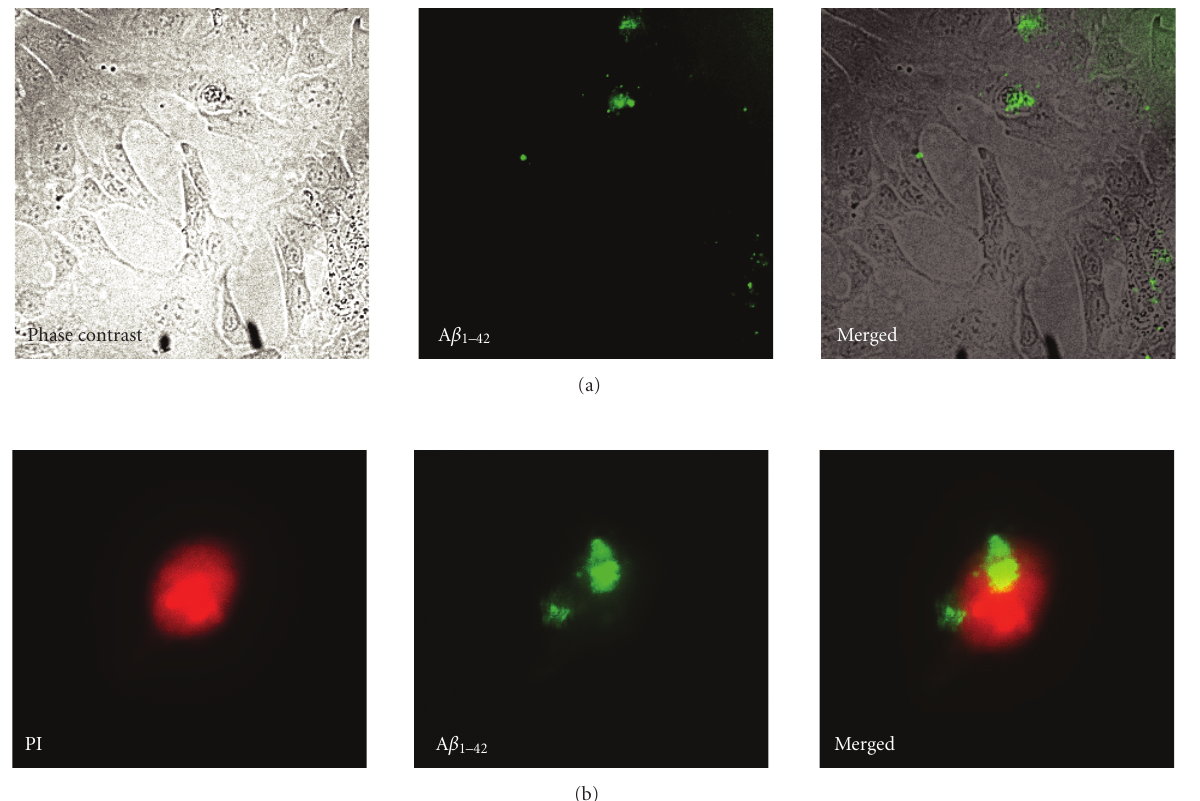
Figure 1: (a)-(b) Uptake of A β 1 – 42 in human microglial cells. The micrographs in (a) show living human CHME3 microglial cells in culture after incubation with A β 1 – 42 , seen by phase contrast and fluorescence microscopy, and after merging of these. The micrographs in (b) show fixed CHME3 microglial cells in suspension after incubation with A β 1 – 42 , seen by fluorescence microscopy with filters for propidium iodide (PI) staining and HiLyte488-conjugated A β 1 – 42 , respectively, and the micrographs are merged in the 3rd micrograph. Magnifications 10 × (a) and 40 × (b).